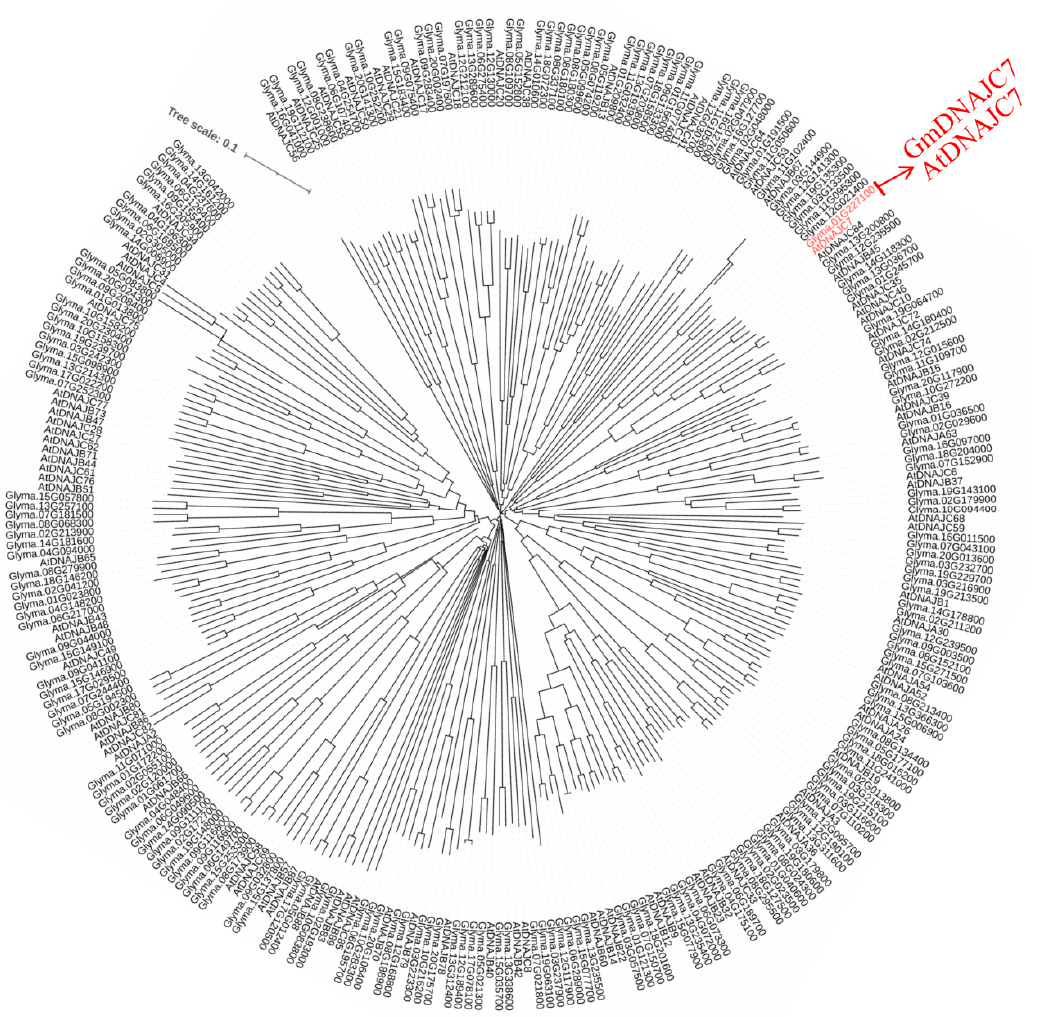
Figure 1. The phylogenetic tree of the DNAJ superfamily proteins in soybean and Arabidopsis . The 204 soybean protein sequences and 89 Arabidopsis protein sequences [15] of the DNAJ superfamily were downloaded from the Phytozome database. The unrooted phylogenetic tree was constructed using MEGA6.0 based on the maximum likelihood (ML) algorithm with 1000 bootstraps, and displayed by iTOL v6 (https://itol.embl.de/, accessed on 7 April 2022).